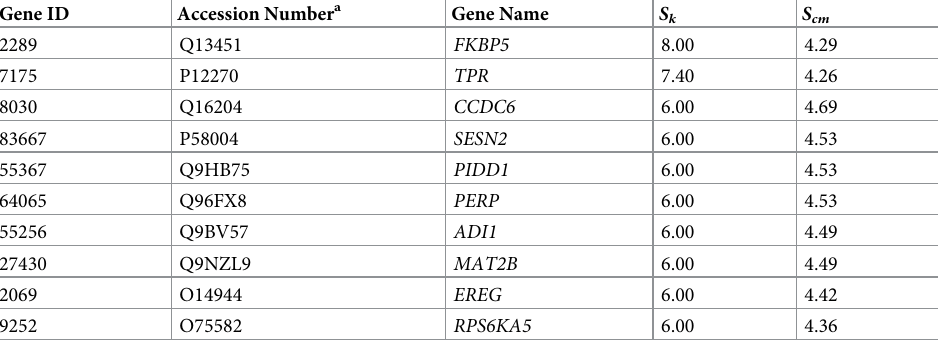
Table 3. Top 10 candidates for HCCPMs selected based on phosphorylation correlation analysis ( S k ) and pathway evaluation ( S cm